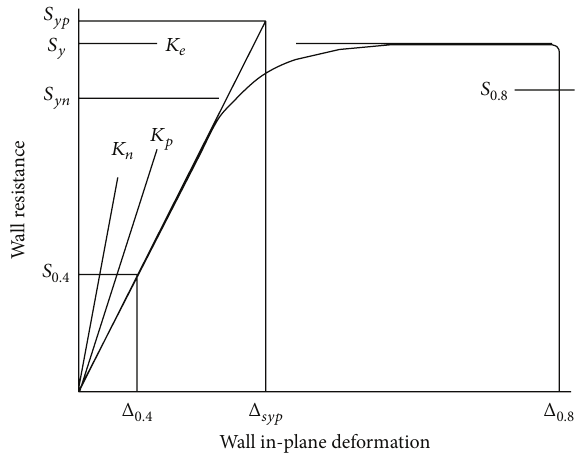
Figure 1: Measured and predicted wall strength and